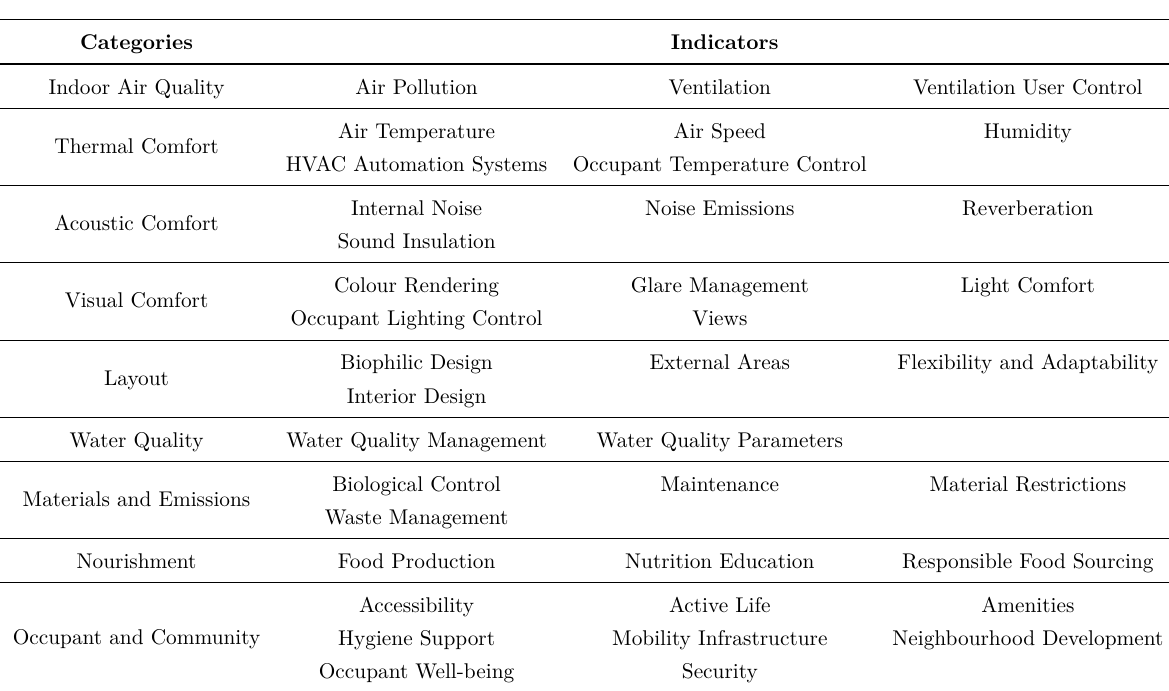
Table 3. Categories and indicators selected for the method to be